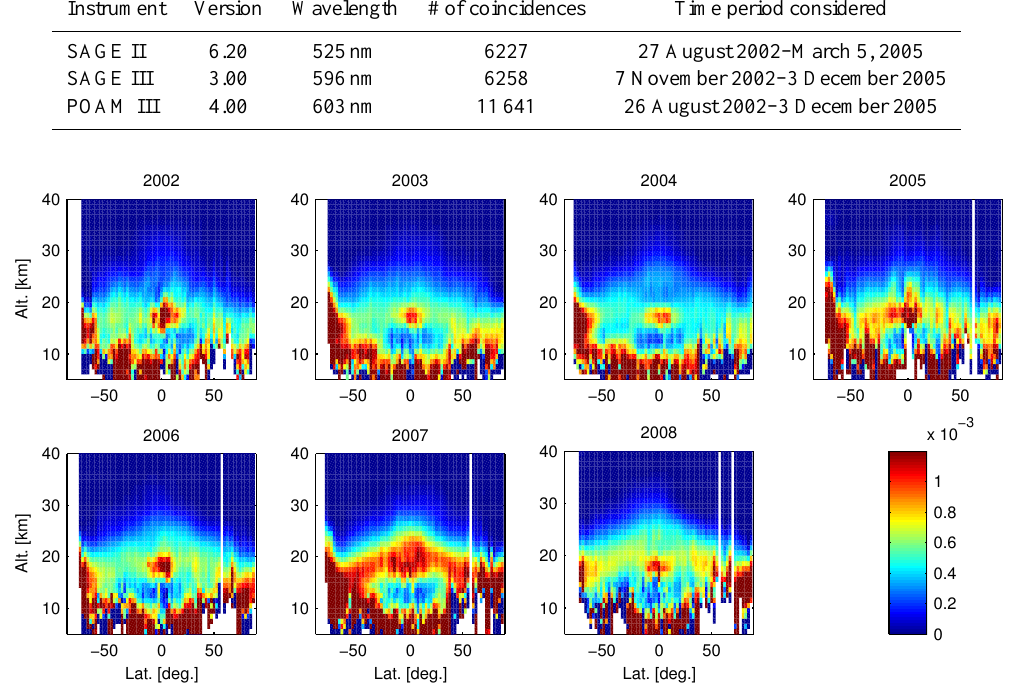
Fig. 4. Yearly zonal median values of (dark limb) aerosol extinction at 500 nm for the entire GOMOS mission. All features that are to be expected are present: the stratospheric aerosol layer, PSCs in the Antarctic region, tropical subvisual cirrus clouds. Notice the enhanced stratospheric aerosol layer in 2007, resulting from the Soufri`ere Hills eruption in May 2006. Years that are sampled incompletely: 2002 (start of the data set: August 2002), 2005 (instrument failure) and 2008 (end of available data set).